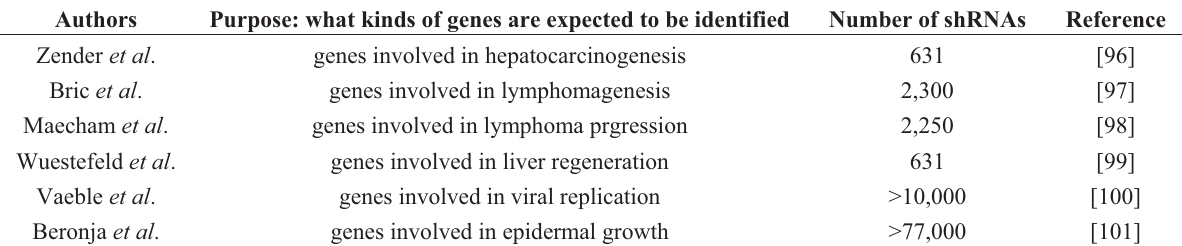
Table 3. In vivo RNAi screens in